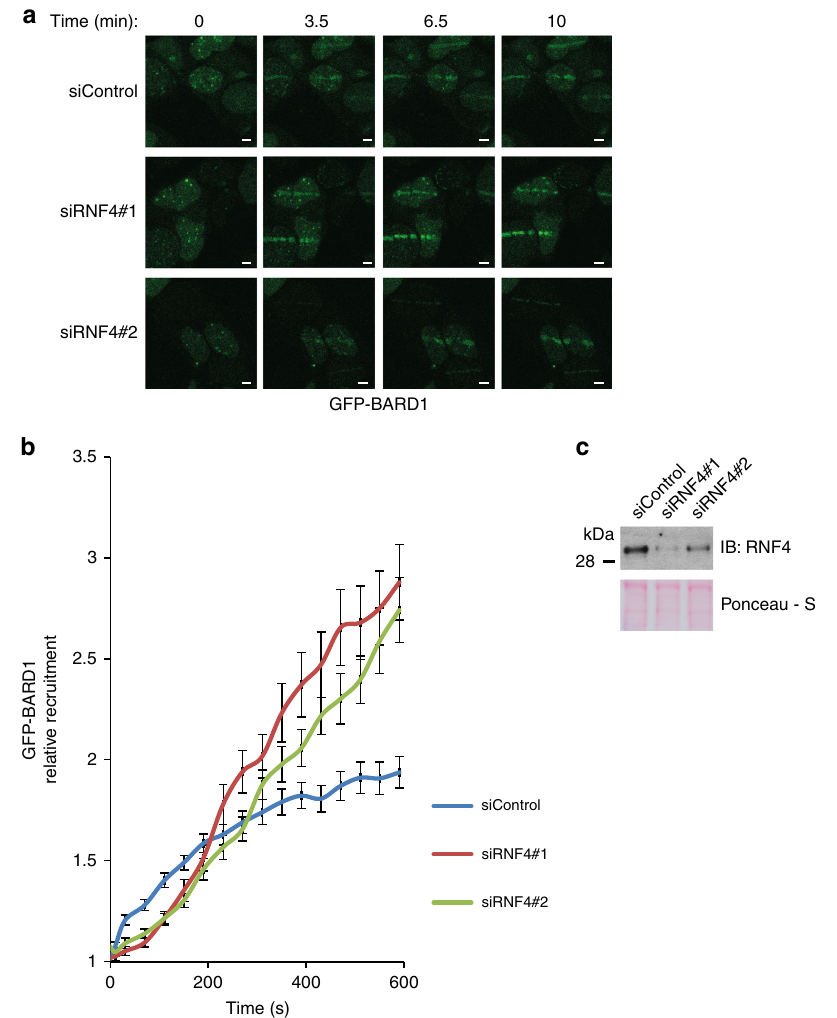
Fig. 9 Accumulation of BARD1 at DNA-damage tracks is regulated by RNF4. a , b U2OS cells were co-transfected with a GFP-BARD1 expression plasmid and two siRNAs directed against RNF4, or with a control siRNA. Two days after siRNA transfection, cells expressing low levels of GFP-BARD1 were treated with laser micro-irradiation. Recruitment of GFP-BARD1 to local sites of DNA damage was studied using time lapse microscopy. a Representative GFP- BARD1 recruitment images from one experiment are shown. Scale bars represent 5 μ M. b Experiments were performed four times. Relative recruitment of GFP-BARD1 to laser-induced DNA-damage tracks was quanti fi ed. Depicted are average values and SEMs ( n > 40). Values from 600 s timepoint were compared using two-tailored t -tests not assuming equal variance ( p -values: siControl vs siRNF4#1 = 1.80 × 10 − 5 ; siControl vs siRNF4#2 = 3.78 × 10 − 5